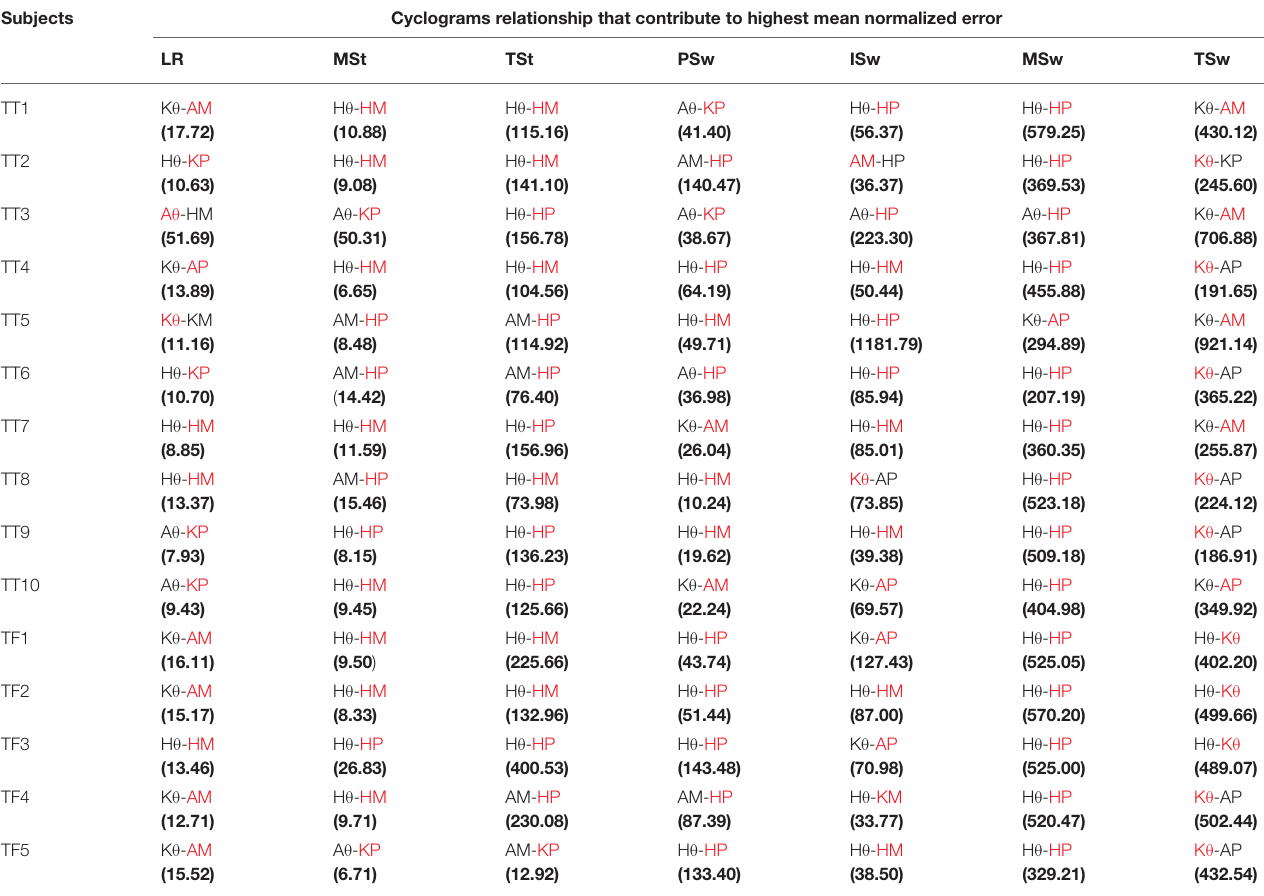
TABLE 4 | Summary of the paired variables that contribute to the highest mean normalized error at respective gait sub-phase for each amputee subject.